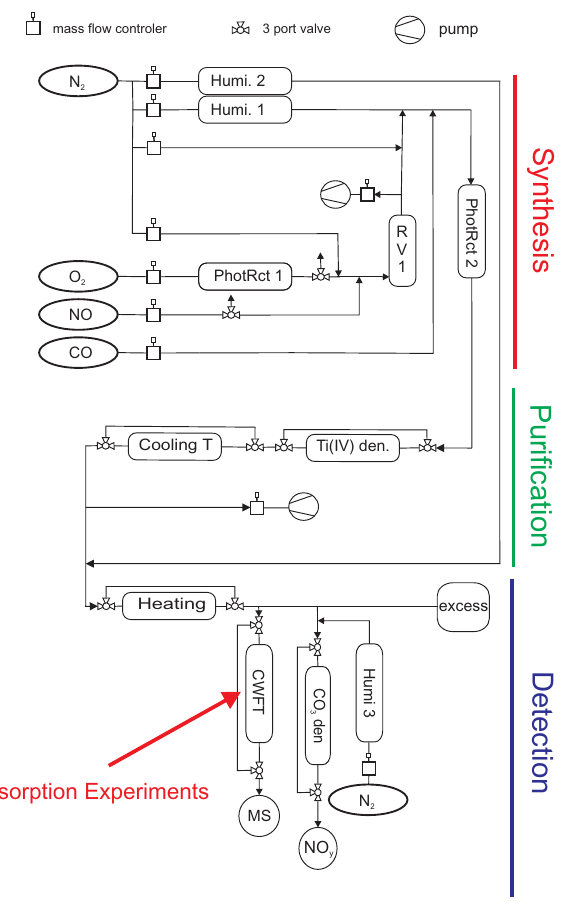
Fig. 1. Experimental setup consisting of a gas-phase synthesis, a purification step, the adsorption experiments (CWFT), and the de- tection